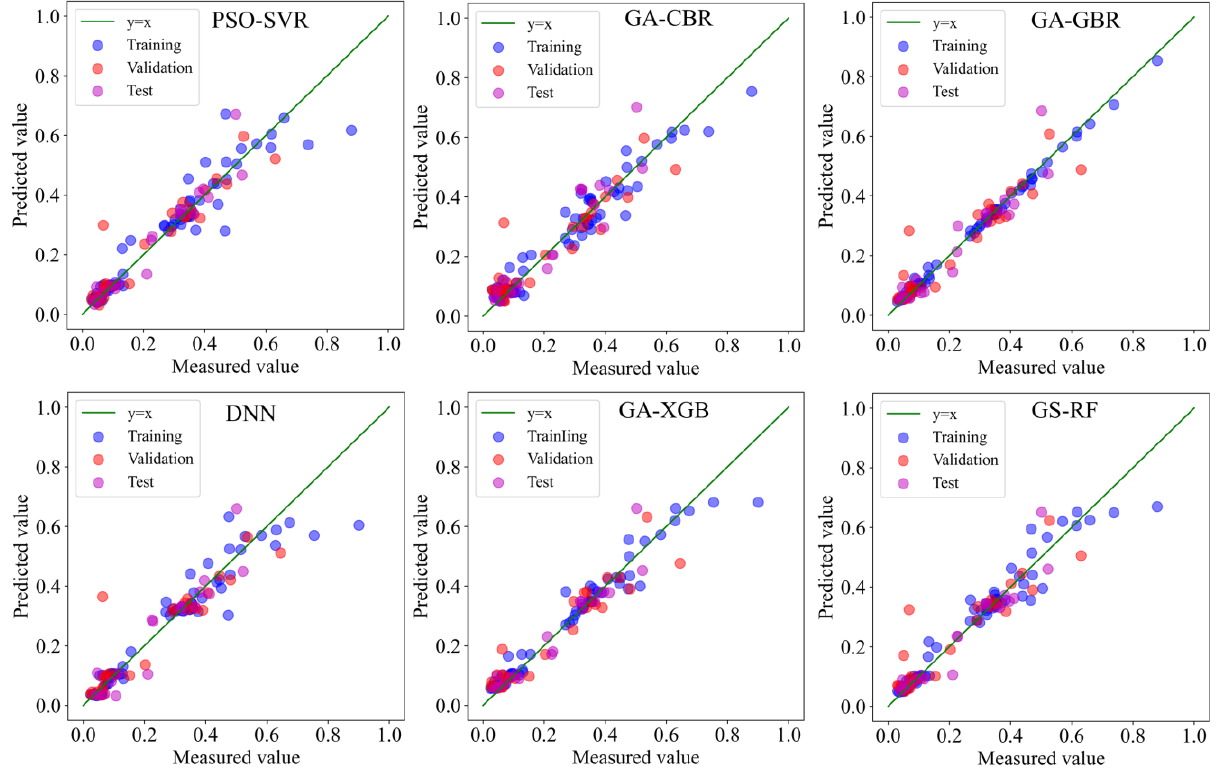
Figure 4. Comparison of measured and predicted TP concentrations of training sets, validation sets, and test sets. Table 5. Performances of the six IOA-ML